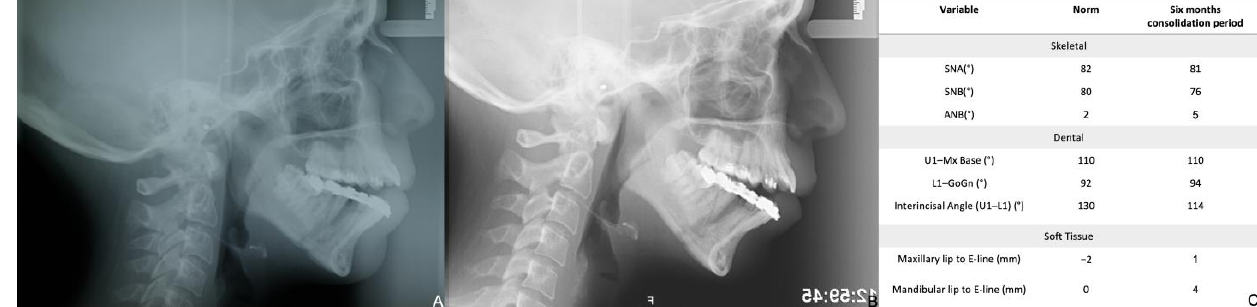
Figure 6. Post-surgical records: lateral cephalogram immediately after the active period of distraction ( A ) and with six months consolidation period ( B ); ( C ) cephalometric measurement with six months consolidation period.